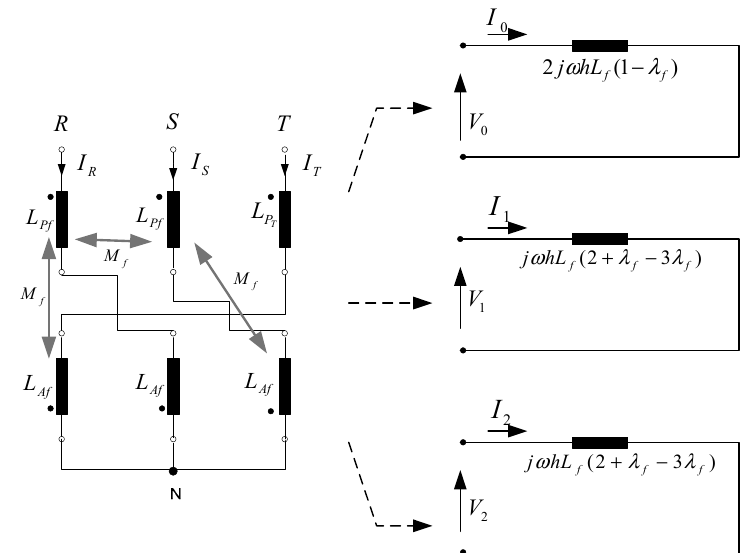
Figure 3. Decoupled sequential circuits.